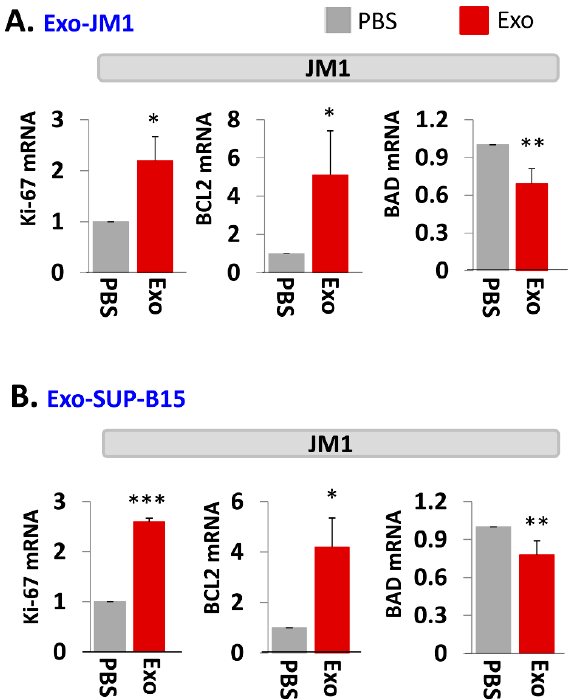
Figure 3. Exo-JM1 and Exo-SUP-B15 regulate proliferative, pro-survival, and pro-apoptotic genes in JM1 cells. ( A ) Exo-JM1 up-regulates Ki-67, and BCL2 mRNA expression (pro-survival) and down-regulates BAD mRNA expression (pro-apoptotic) in autocrine manner. ( B ) Exo-SUP-B15 promotes Ki-67 and BCL2 mRNA expression and down regulates BAD expression in JM1 cells in paracrine manner. Data represented are mean of three experiments. (Ctrl: PBS only—no exosomes. p -value * p < 0.05, ** p < 0.01, *** p <